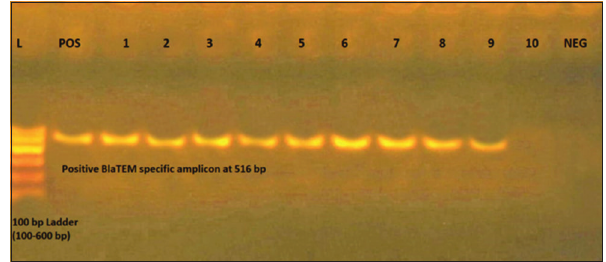
Figure-1: From the left to the right: Lane L: 100 bp ladder (100-600 bp), POS: Positive bla control at 516 bp, Lanes TEM (1-9): Specific amplicon at 516 bp, Lane 10: Negative result no amplicon, NEG: Negative control.